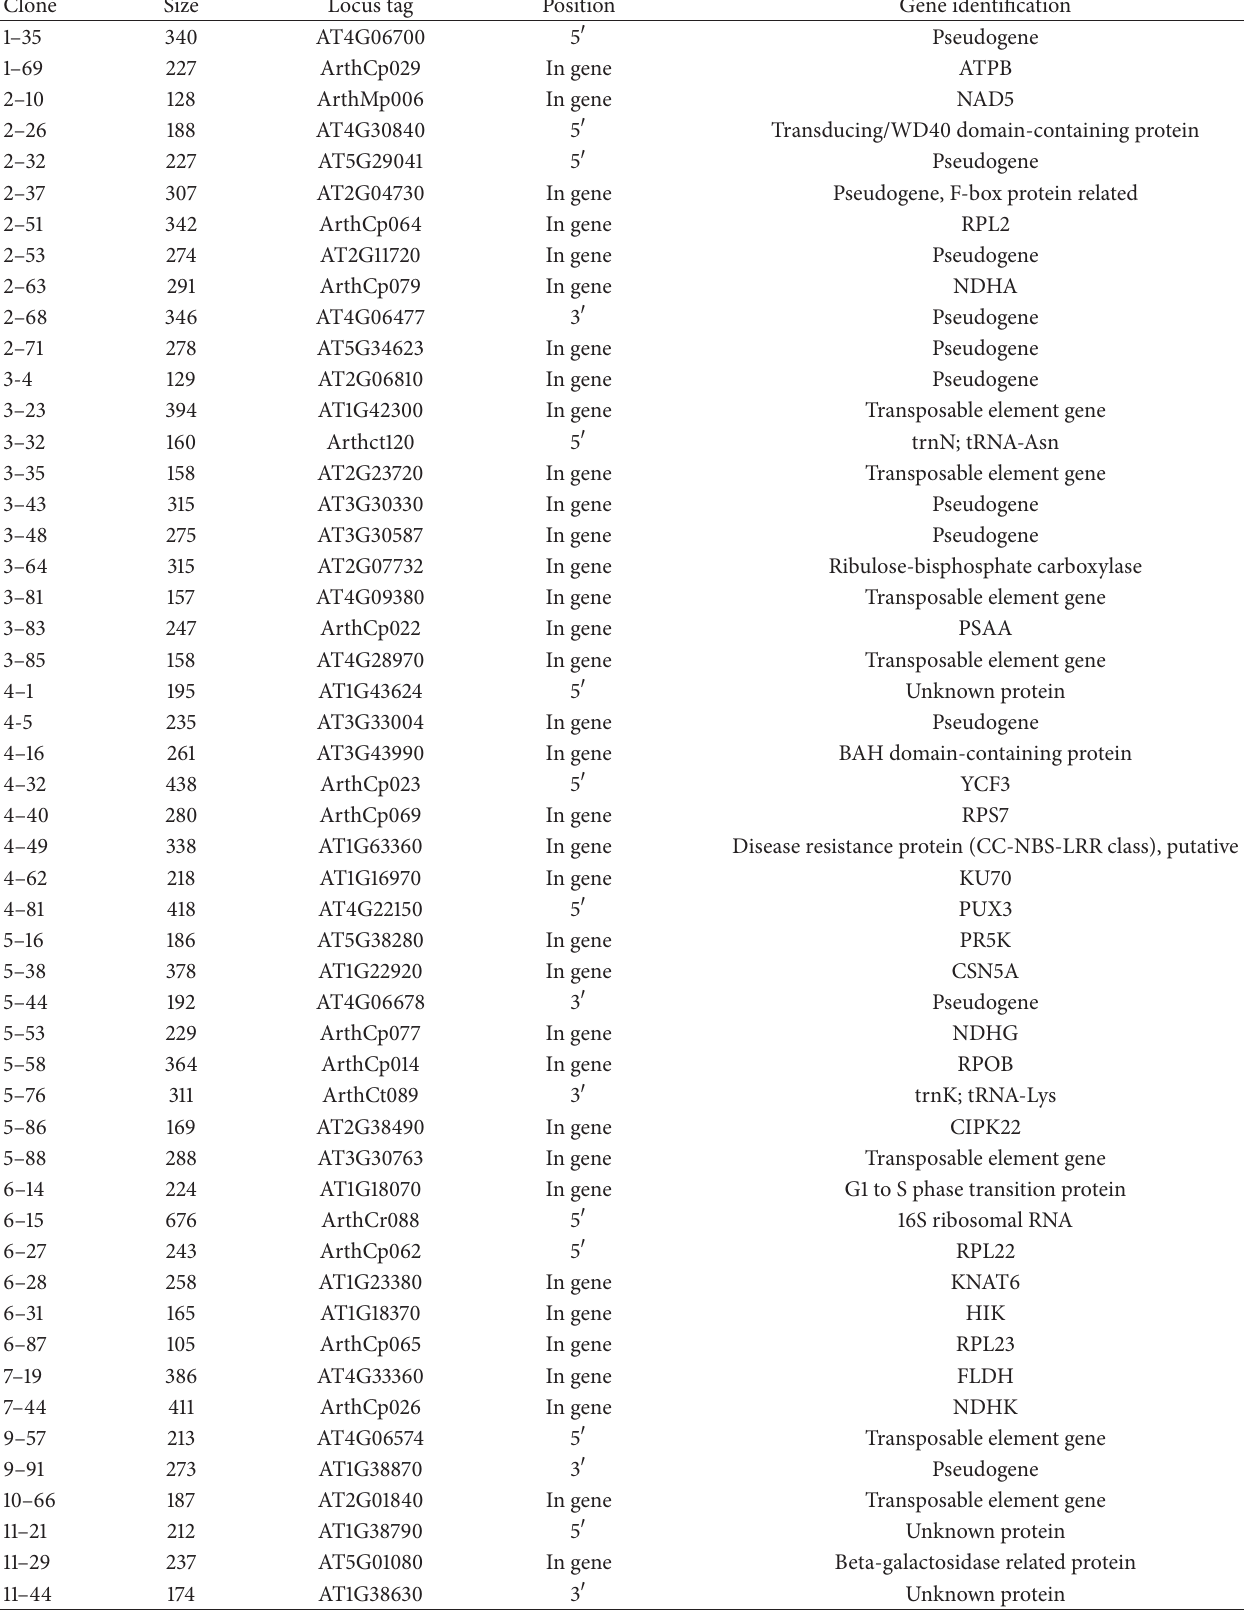
Table 3: Analysis of the sequencing results of some clones from the differential-methylation subtractive